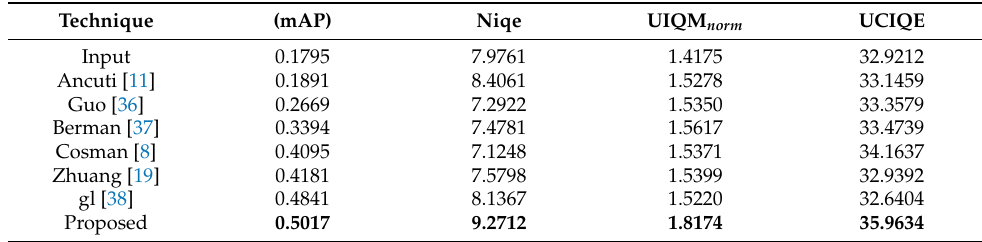
Table 4. Average mAP, niqe, UIQM norm , UCIQE comparison of different techniques whose results are partially presented in Figure 8. The best result is bold.